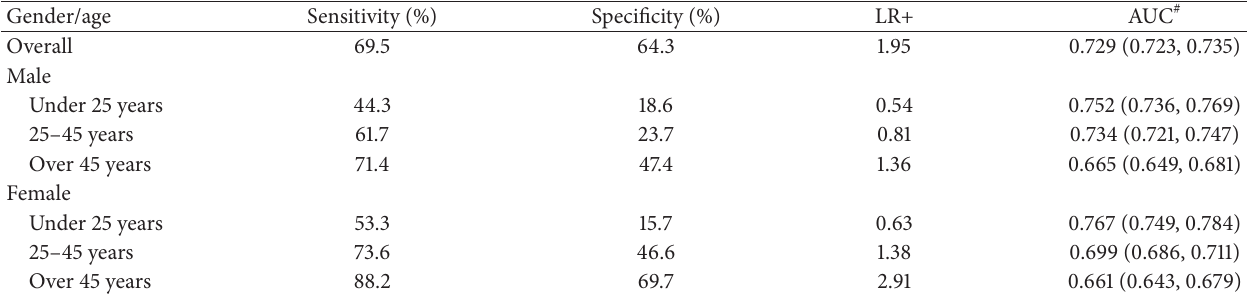
Table 2: Sensitivities, specificities, LR+, and AUCs of the McMonnies questionnaire in different gender/age groups at a recommended cut-off point of 14.5 ∗ .